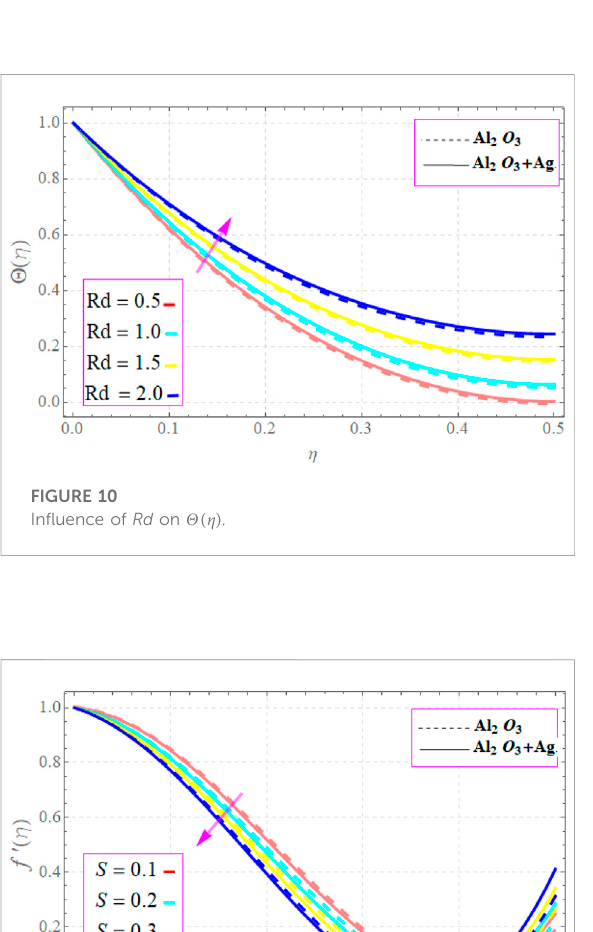
FIGURE 12 In fl uence of S on Θ ( η ) .